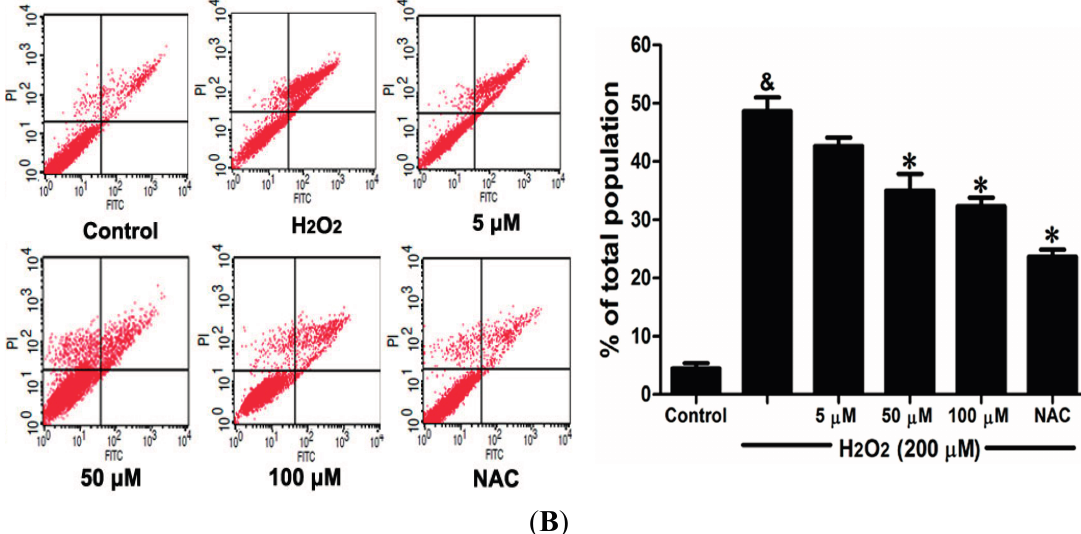
Figure 7. DSC inhibited H 2 O 2 -induced mitochondrial membrane potential ( ΔΨ m ) loss and apoptosis in HUVEC. HUVEC were incubated with indicated concentrations of DSC or NAC for 4 h, then stimulated with H 2 O 2 (200 μ M) for 2 or 12 h; the ΔΨ m ( A ) and apoptosis ( B ) were measured by flow cytometry, respectively. Data shown are means ± SEM, & p < 0.05 compared with unstimulated cells, * p < 0.05 compared with H 2 O 2 -stimulated cells. Data were from at least three independent experiments, each performed in